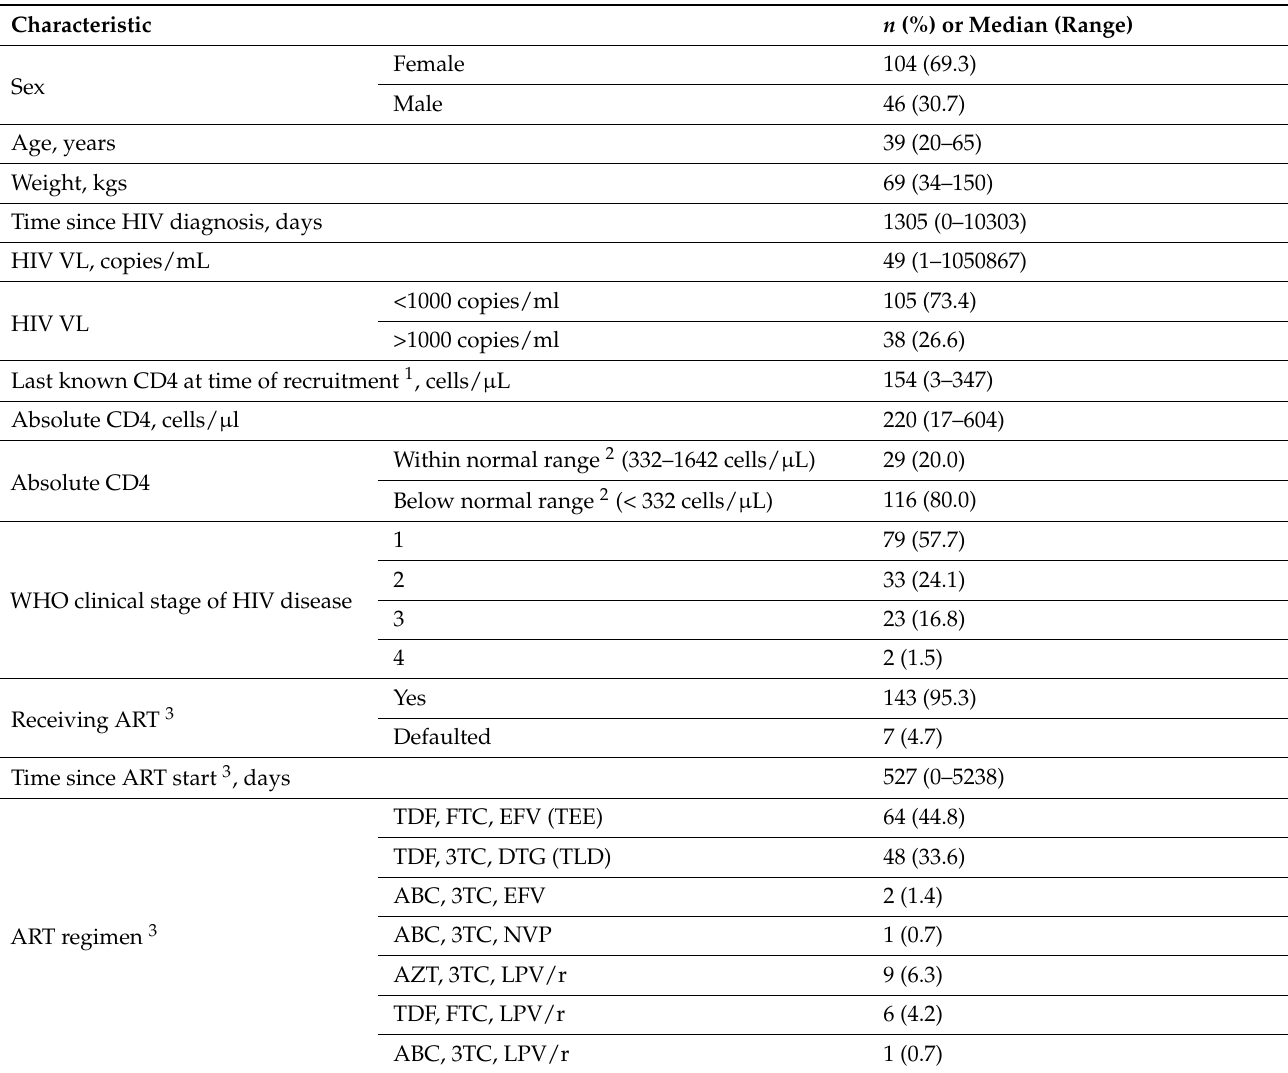
Table 1. Selected baseline demographic and clinical characteristics of the patient cohort ( n = 150). All patients were HIV positive adults and were recruited with a last known CD4 count < 350 cells/ µ L. Data are presented as number and percentage of total or median and range as appropriate. Partici- pants with missing data are excluded per